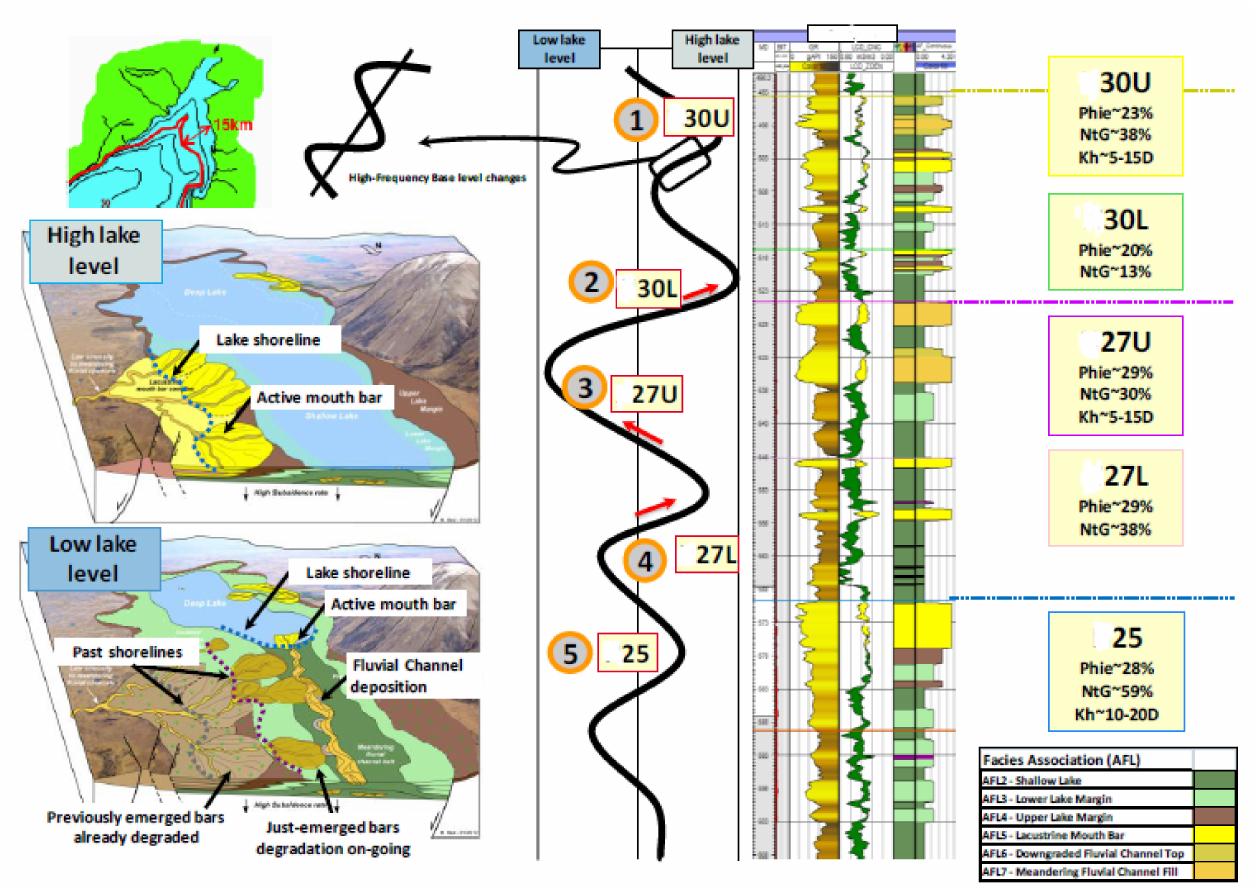
Figure 3. Lithology sequences of the studied field.